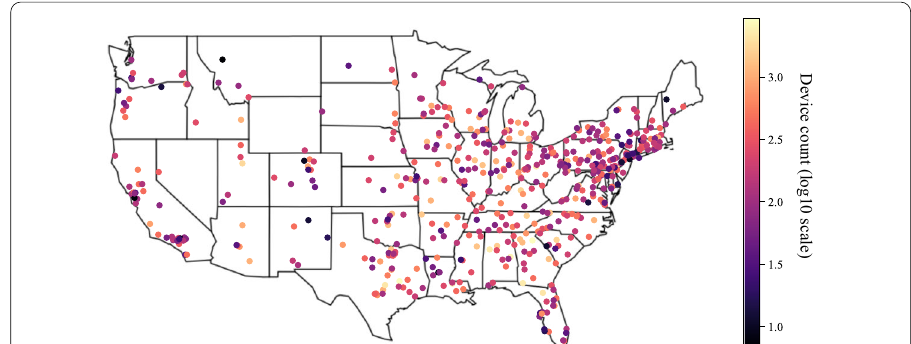
Fig. 1 Device count and location of college clusters. Though the simulation includes a small number of agents located in Puerto Rico and Hawaii, they were excluded from this figure